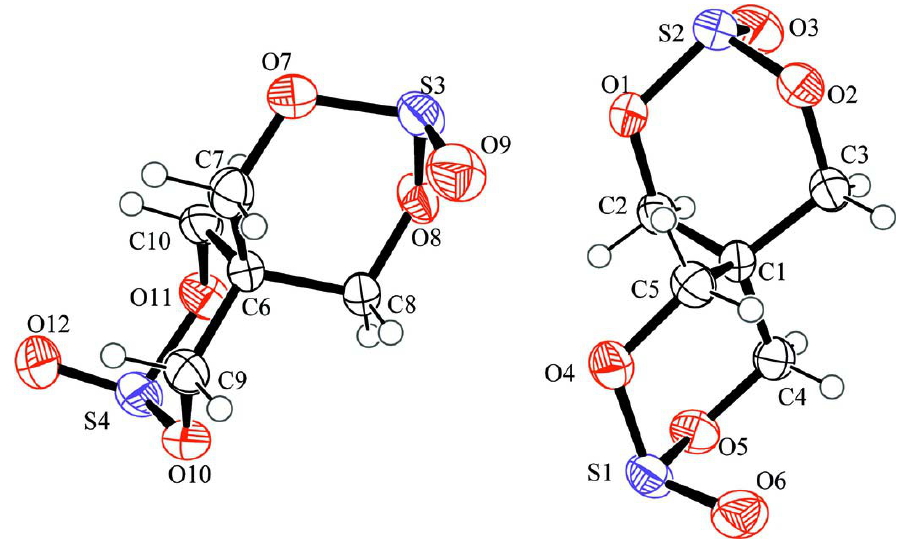
Figure 1 The molecular structure of (I) showing the atom-labelling scheme. Displacement ellipsoids are drawn at the 50% probability